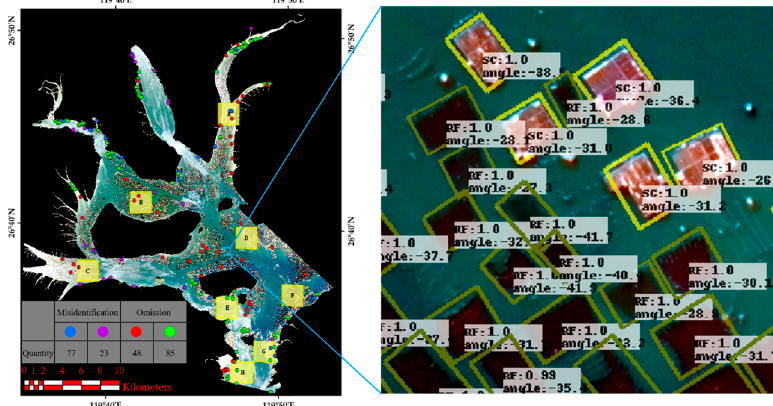
Figure 9. Extraction results of aquaculture zones in the test set ( left ) and the enlarged panel showing the extraction details ( right ). The green dot represents missed cages; the purple dot represents misidentified cages; the red dot represents missed rafts; the blue dot represents misidentified rafts.